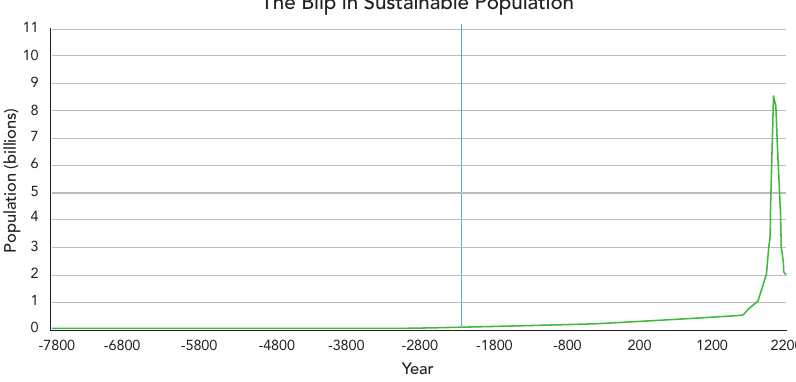
Figure 1. The Blip in Sustainable Population from 8800 bce to the end of the twenty-first